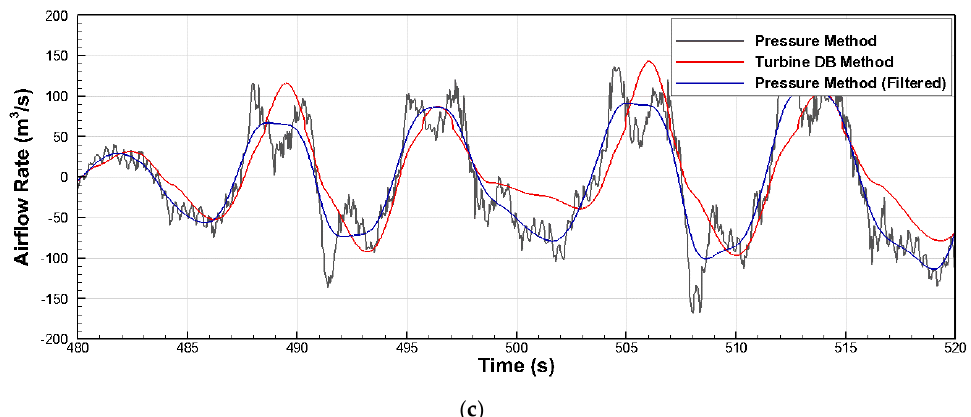
Figure 6. Comparison for results of airflow rate evaluation between the pressure method and the turbine DB method. ( a ) Time window = 0–1500 s; ( b ) Time window = 400–600 s; ( c ) Time window = 480–520 s.